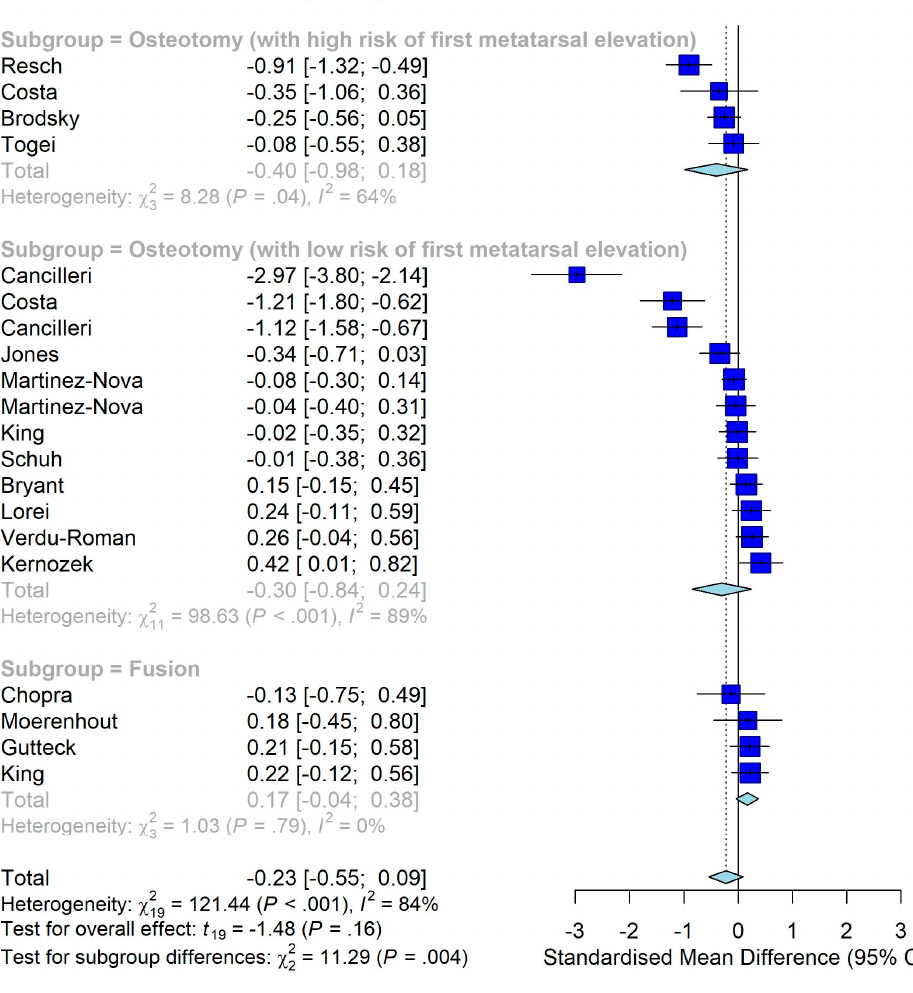
Figure 4. Meta-analysis on the overall effects of surgeries on plantar load over medial metatarsal region (increase means better) [24,25,32–38,41,42,44,46,49,50,53,54].